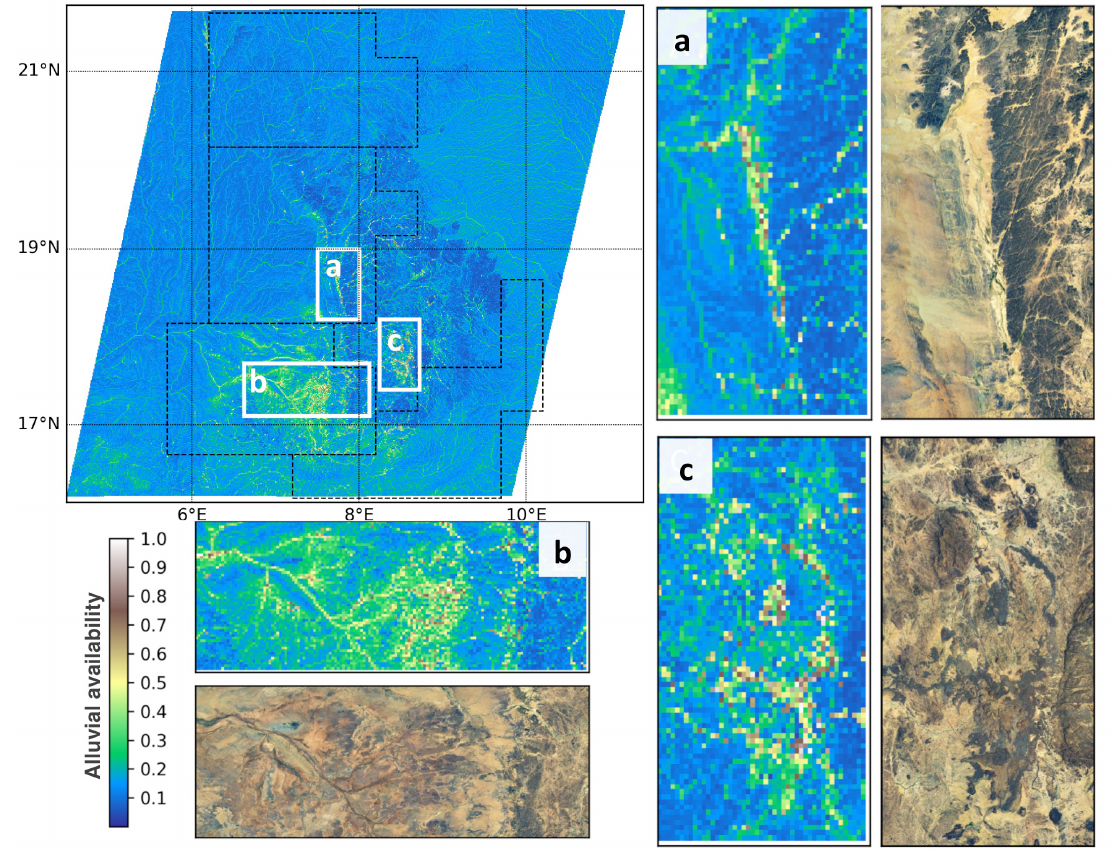
Figure 7. Alluvial Fines Map (AFM) derived from combination of HydroSHEDS FA dataset and the hue transformed band of Sentinel-2 channels 12-7-4. Values close to 1 represent high availability of alluvial sediments. Subsets ( a ), ( b ) and ( c ) show subsets of the AFM map within the study area together with the respective Blue Marble